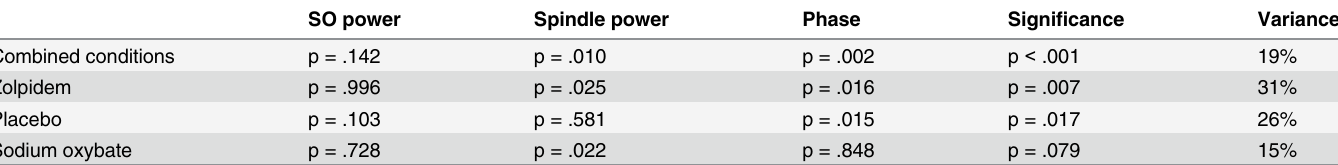
Table 3. Regression results for the combined conditions and each condition